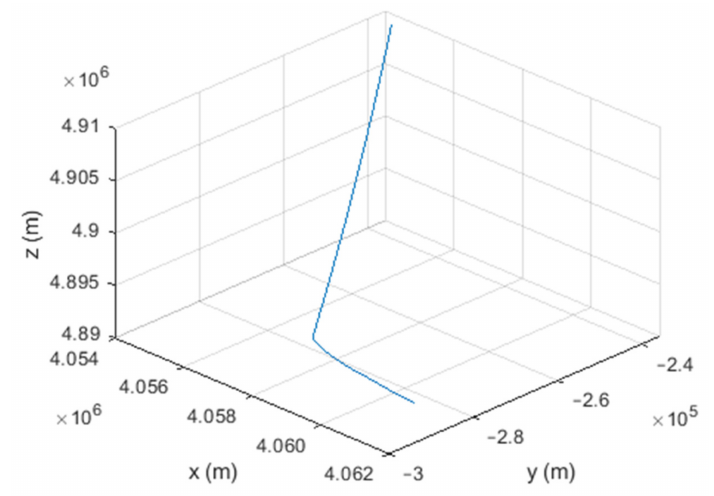
Figure 4. The trajectory of the first scenario: moving at a speed of 90 m/s.